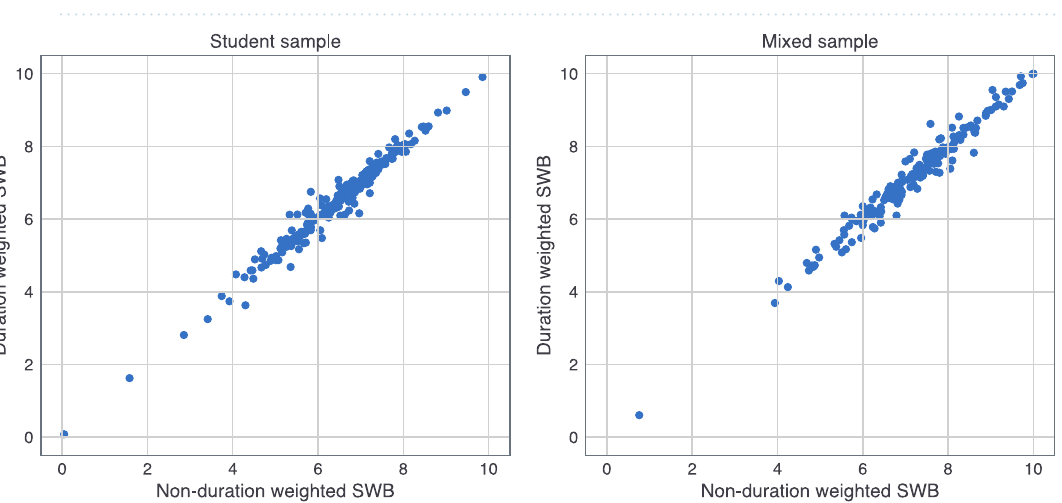
Figure 1. Mean SWB (happiness intensity × duration) scores with and without duration weights, for each questionnaire type and sample.